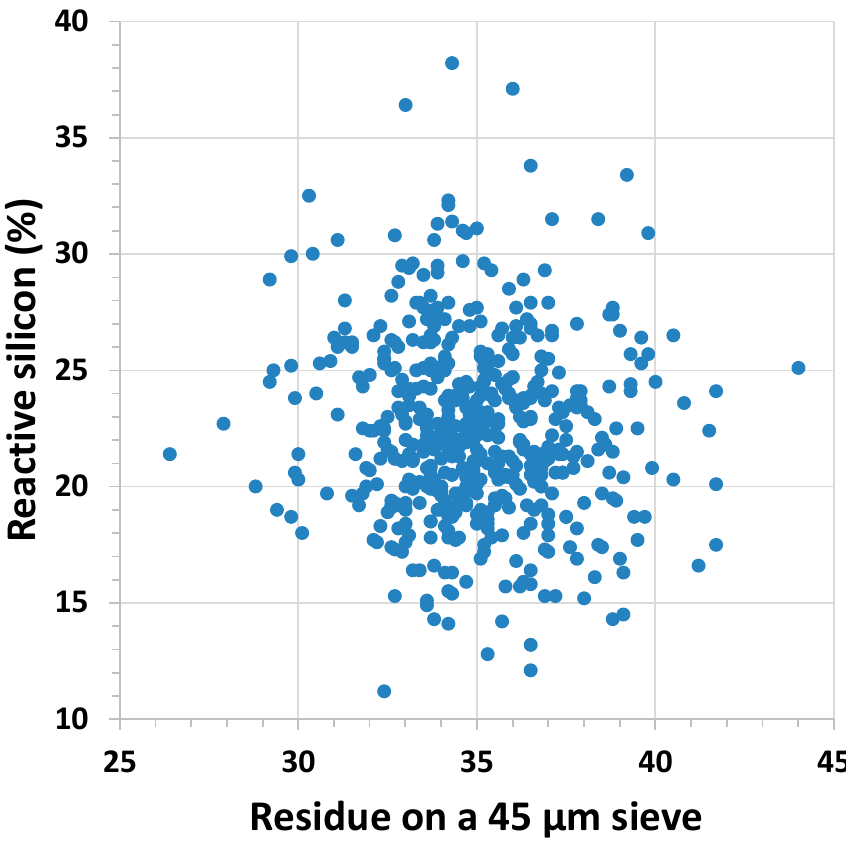
Figure 4. Relationship between reactive silicon and 45 µm residue.